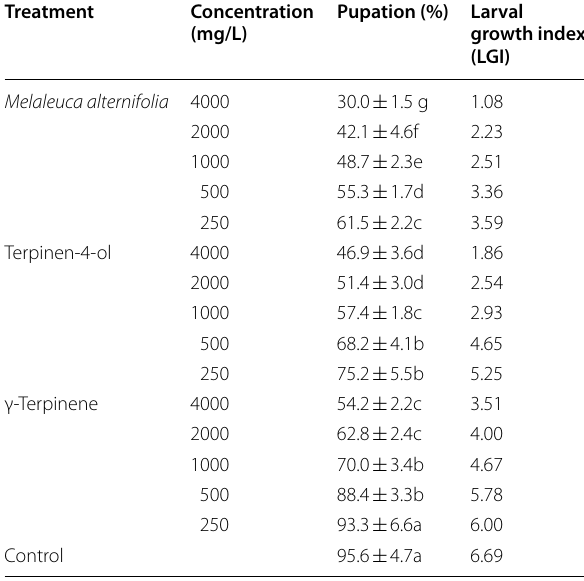
Table 4 Larval growth index (LG) of 2nd instar Spodoptera littoralis larvae fed for 72 h on treated castor bean leaves by Melaleuca alternifolia EO, terpinen-4-ol, and γ-terpinene at different